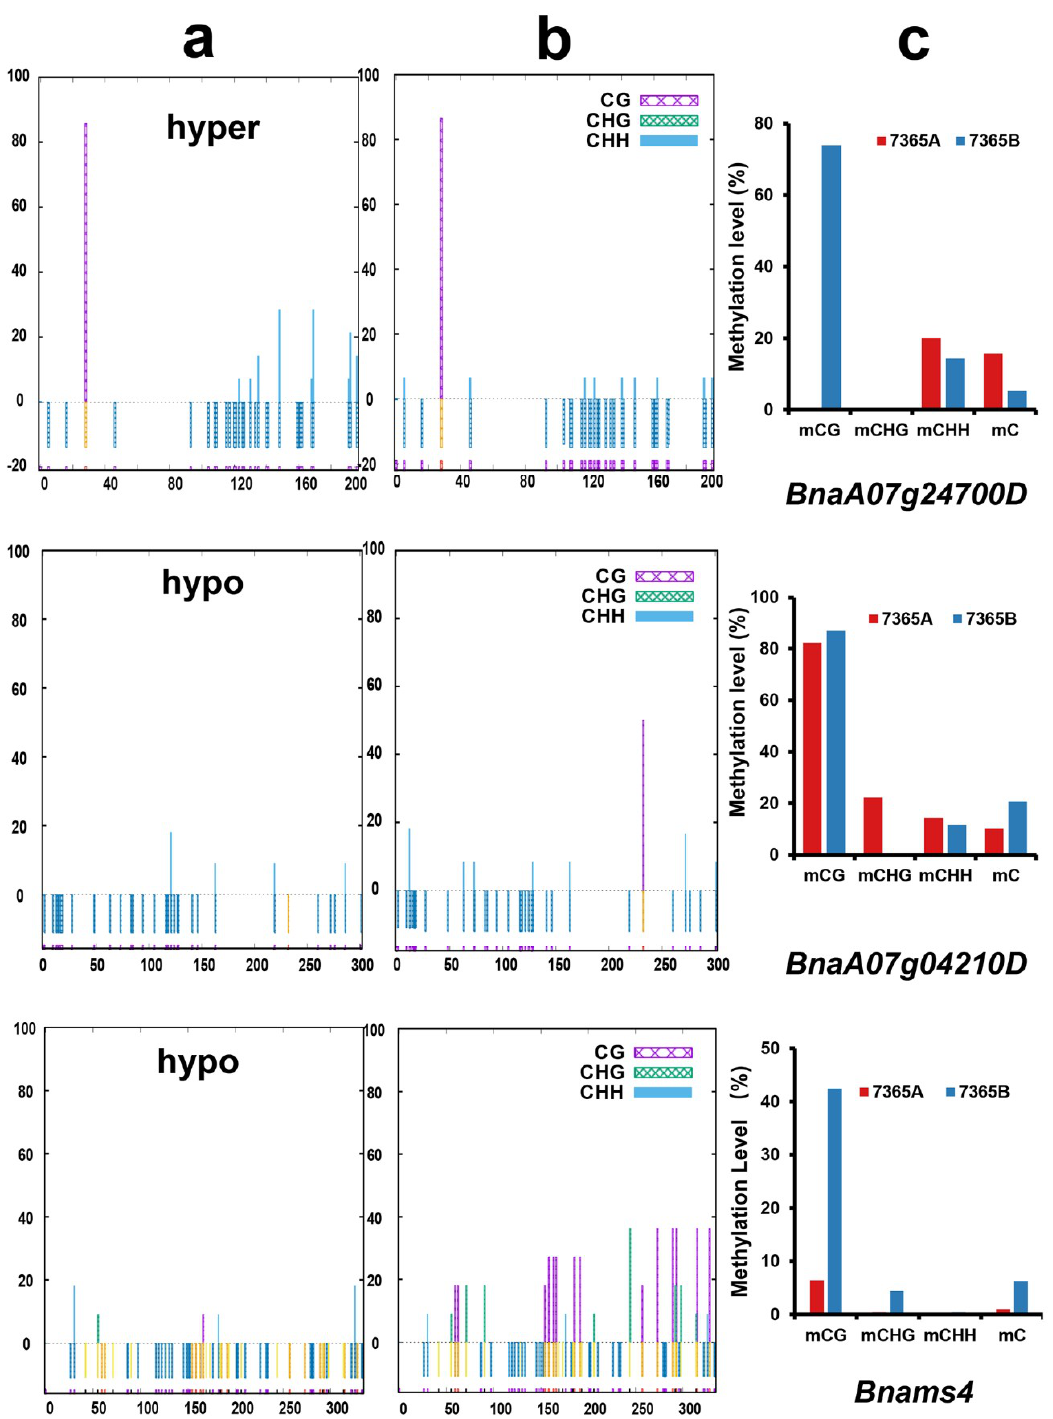
Figure 7. DNA methylation at specific sites of two DMGs and Bnams4 by traditional bisulfite sequencing. ( a ) Bisulfite PCR results in 7165A; ( b ) Bisulfite PCR results in 7365B. The vertical axis represents the percentage of methylated sites; the horizontal axis represents the position of cytosine in the DMRs; hypo and hyper represents hypo‐methylated and hyper‐methylated DMR in 7365A. ( c ) WGBS results of the corresponding DMR.